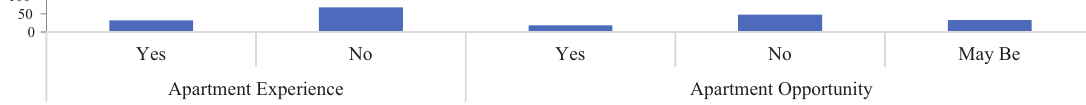
Figure 7. Prior experience of living in S.U. houses and apartment buildings and apartment residence opportunity